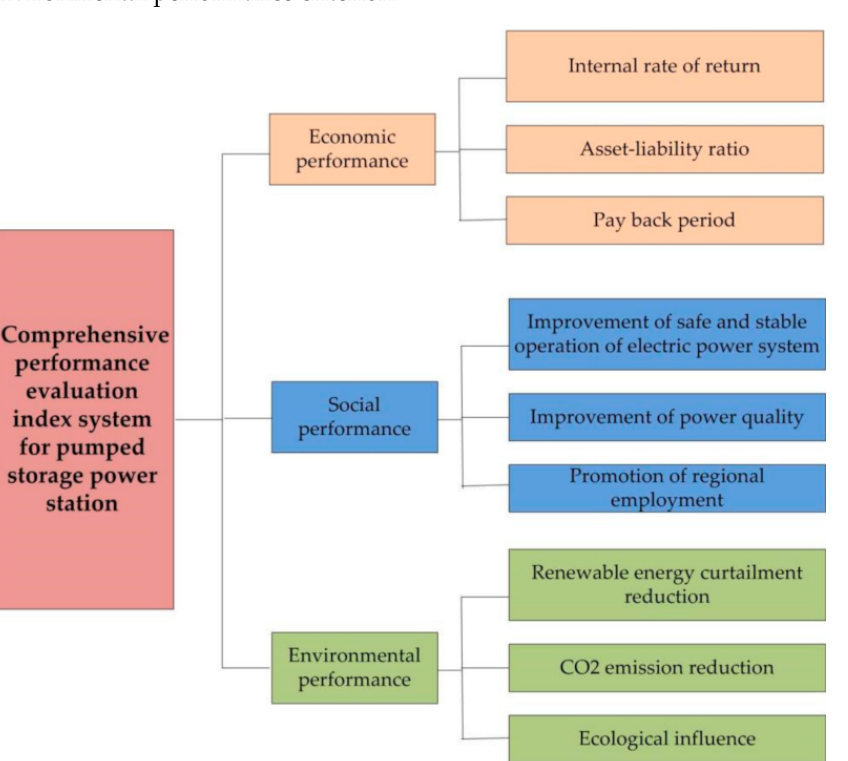
Figure 1. Comprehensive performance evaluation index system for pumped storage power